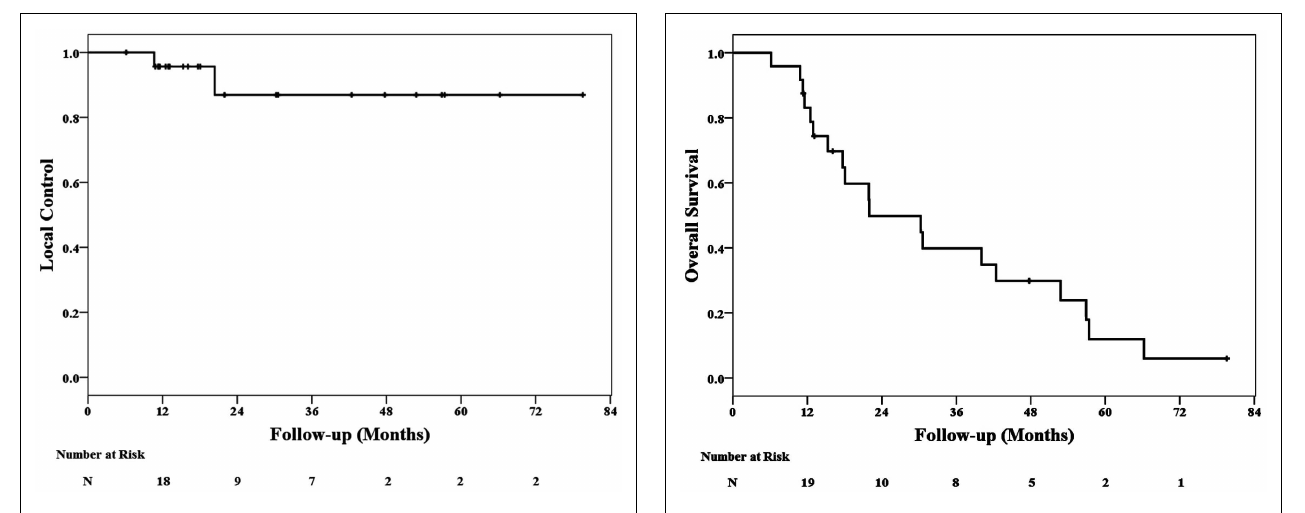
FIGURE 1 | Kaplan–Meier local control plot. FIGURE 2 | Kaplan–Meier overall survival